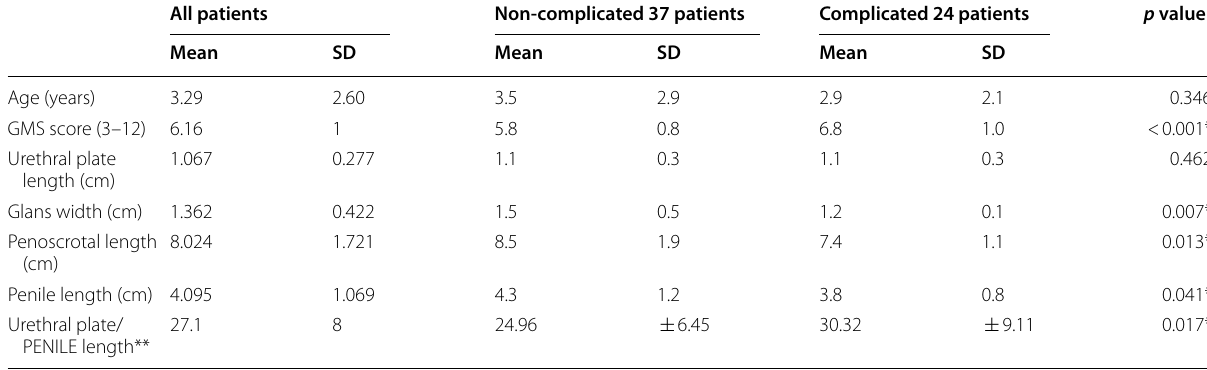
Table 3 Mean values of GMS score and penile parameters in complicated and non-complicated cases